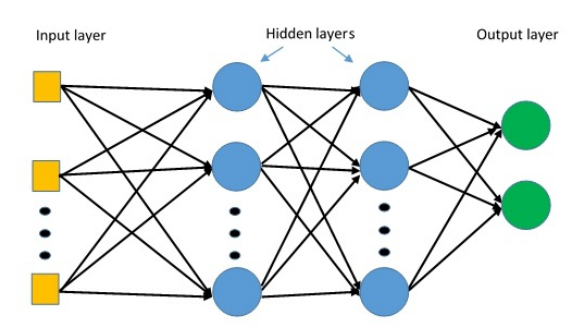
Figure 5. A multi-layer perceptron with two-hidden layers.